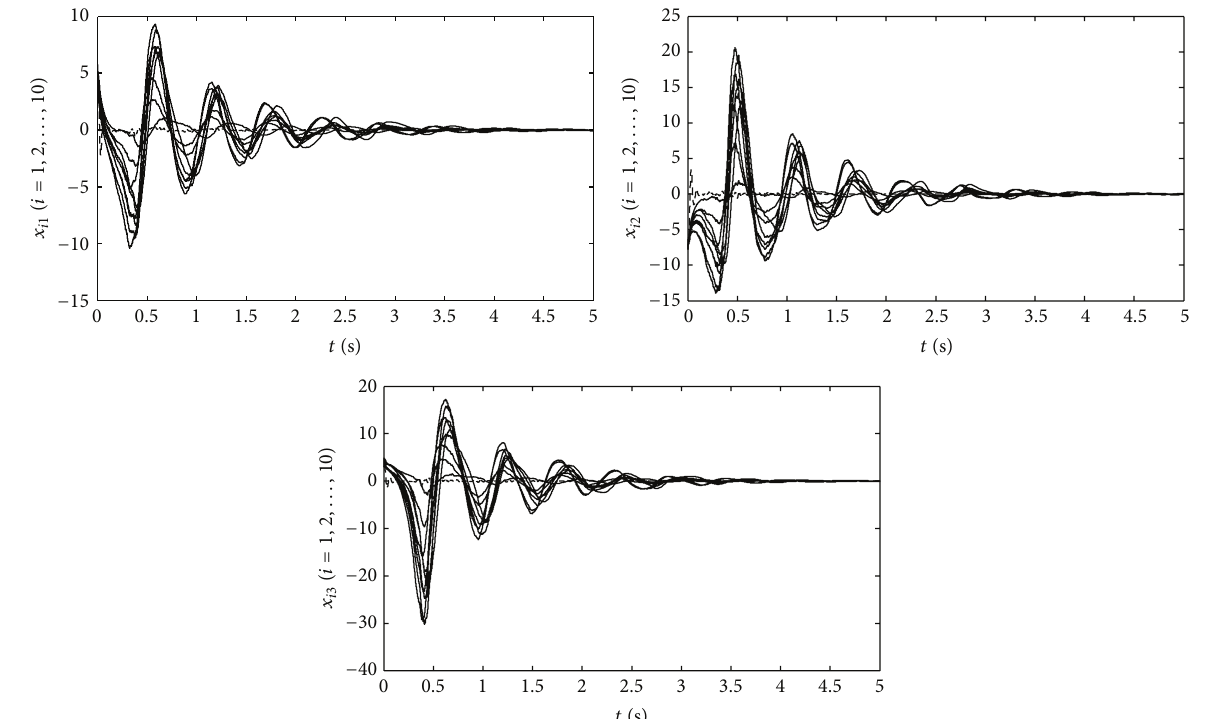
Figure 3: The states of complex network coupled with an asymmetic and irreducible